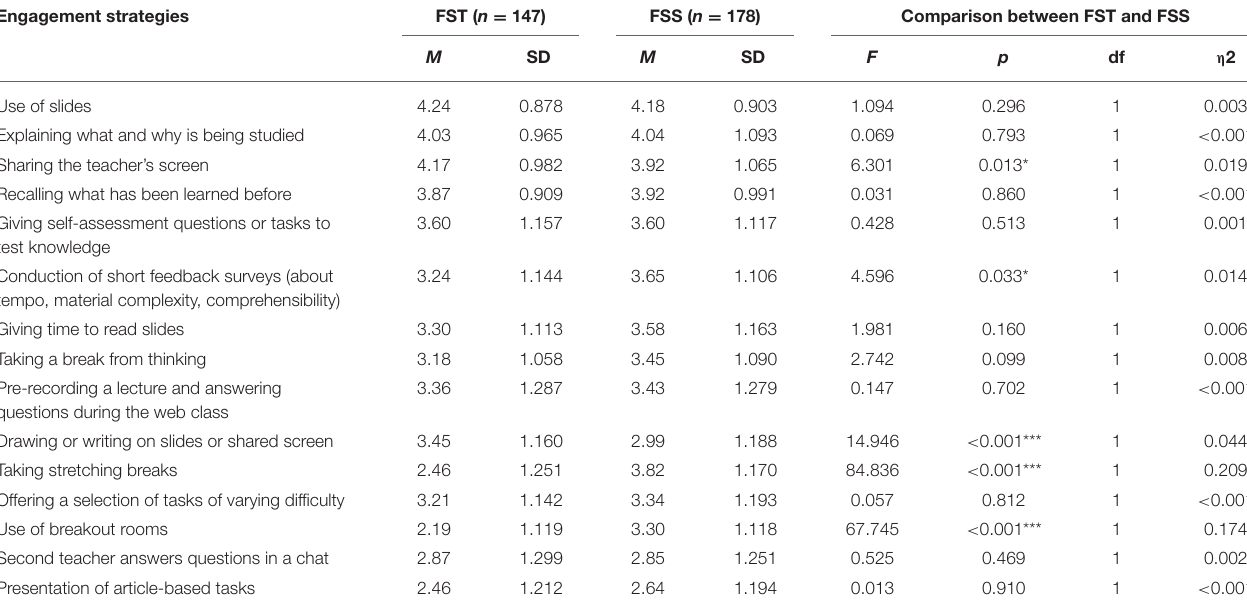
TABLE 4 | Comparison of ratings of student engagement strategies between students from the two disciplines. Engagement strategies FST ( n = 147) FSS ( n = 178) Comparison between FST and FSS